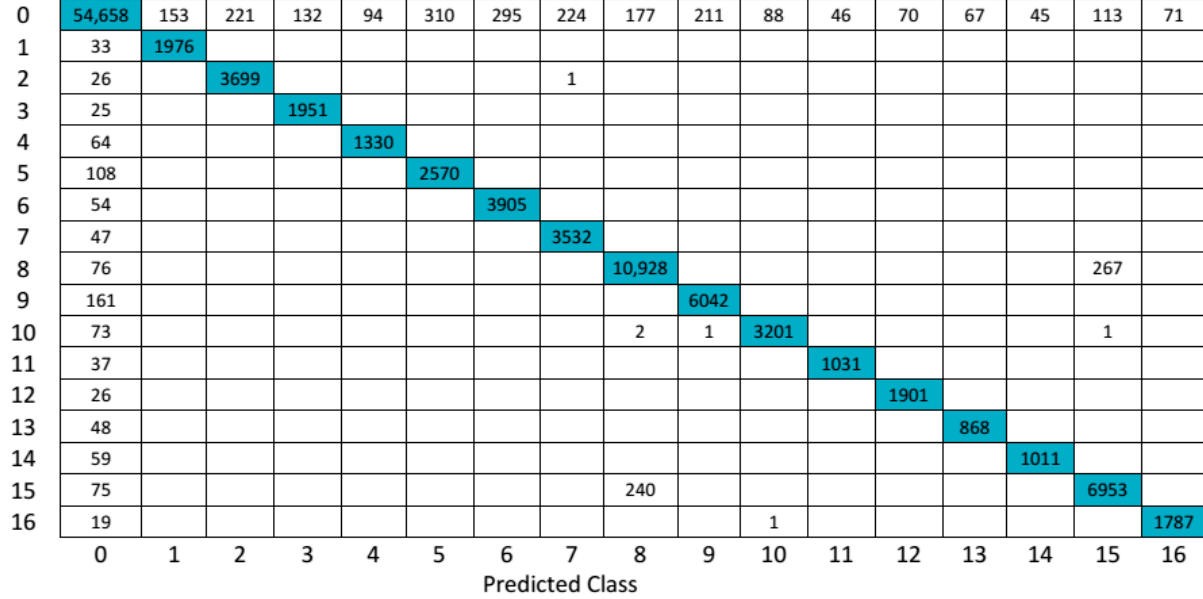
Figure 9. Confusion matrix for 3D-DWT+SVM (Fejer-Korovkin filters) in Salinas hyperspectral data.